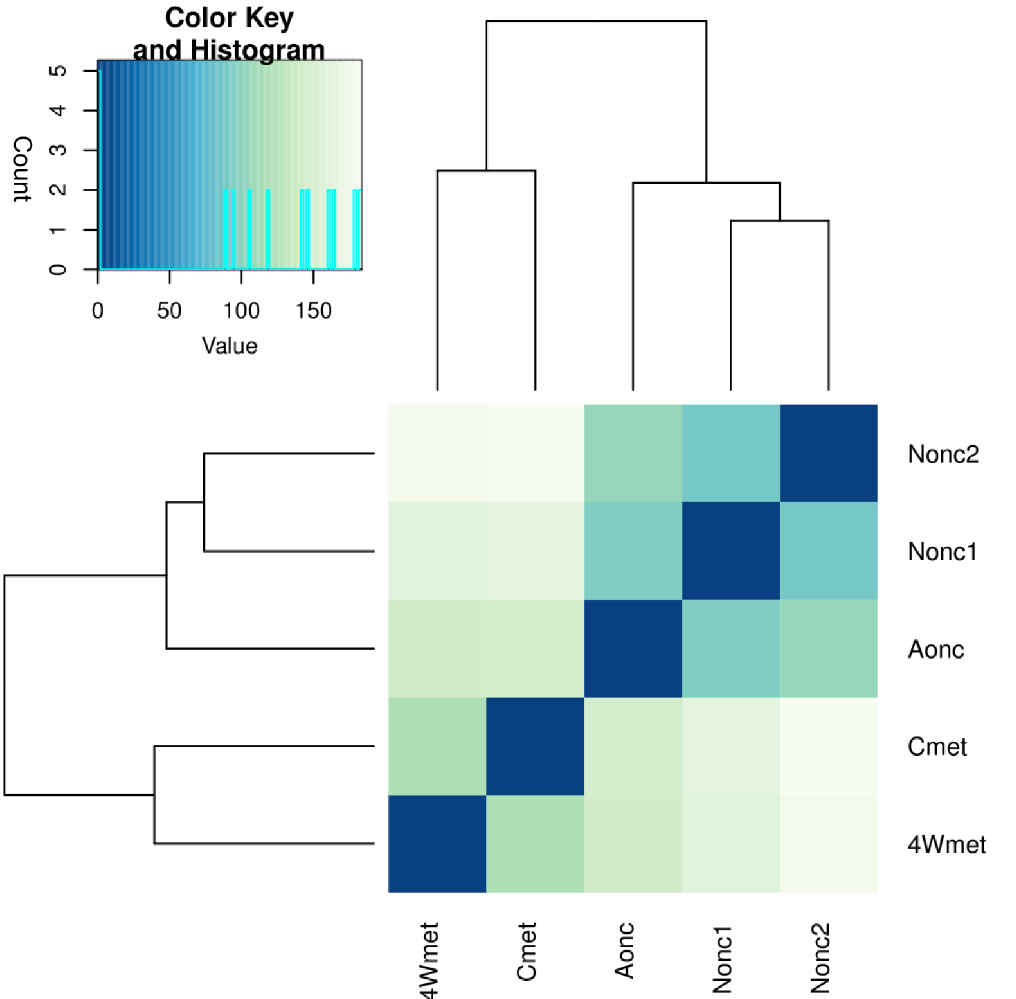
Fig 3. Heatmap showing the Euclidean distances between the samples as calculated from the variance stabilizing transformation of the count data by DEGseq pakage [33]. Nonc1: Non-activated oncosphere 1; Nonc2: Non-activated oncosphere2; Aonc: Activated oncosphere; 4Wmet: